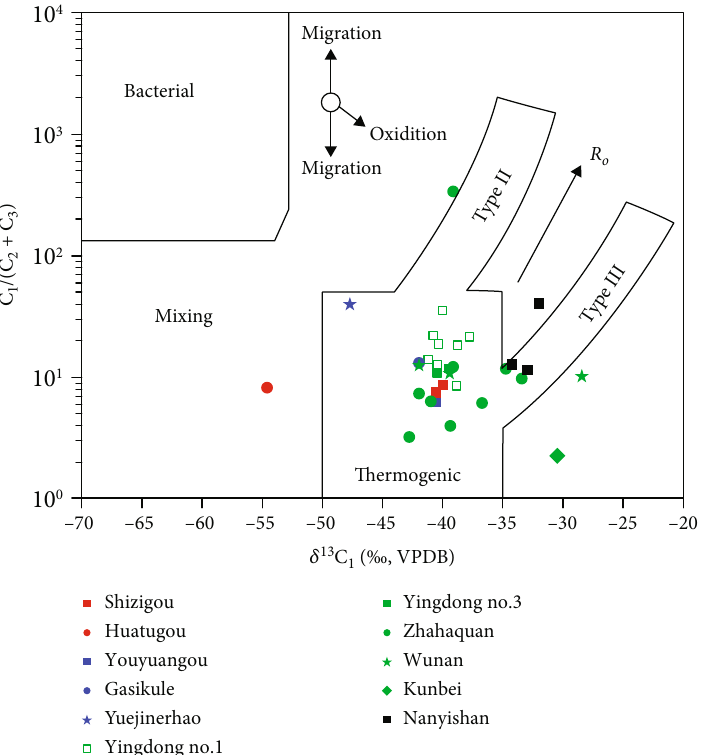
Figure 5: Diagram of C